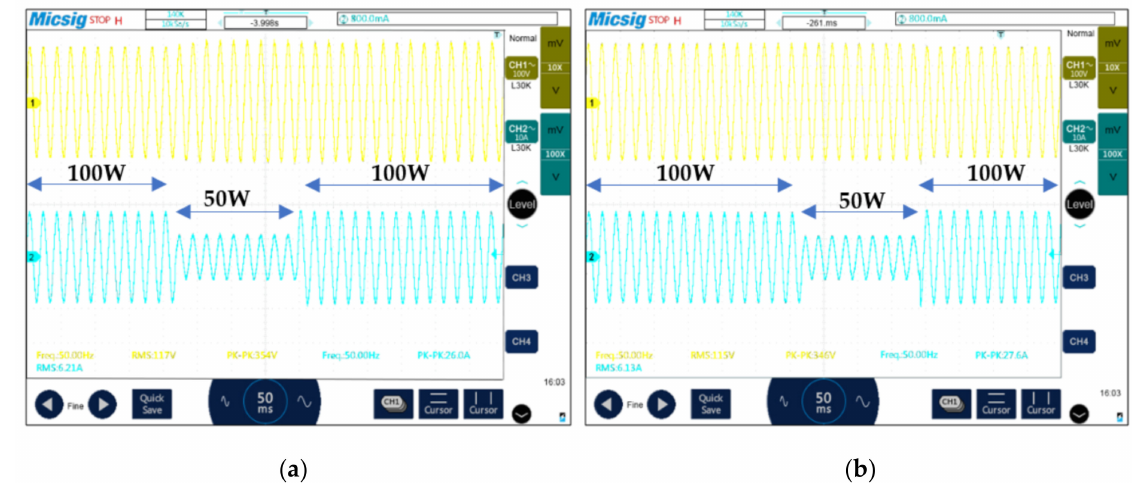
Figure 12. Load-Transient response for 100 W to 50 W step load change (Yellow—Output AC voltage, Blue—Output current): ( a ) Standalone 12 V–120 V inverter; ( b ) After applying the SCAWI-PV